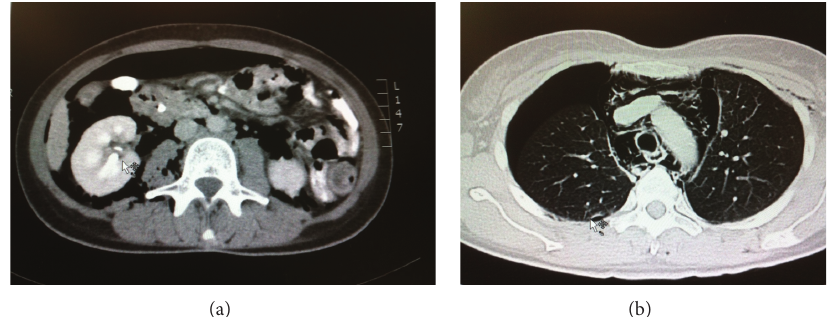
Figure1:(a)AbdominalCTscanshowingintra-andretroperitonealfreeair.(b)ThoracicCTshowingright-sidedpneumothoraxandpresence of mediastinal air.